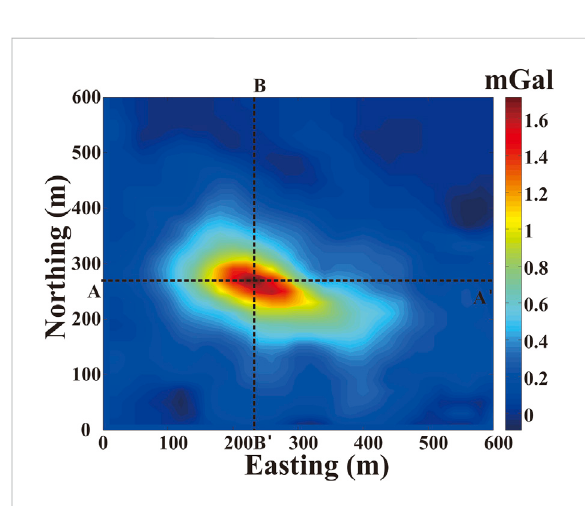
FIGURE 9 Residual bouguer anomaly map of the Mobrun ore body, northeast of Noranda,